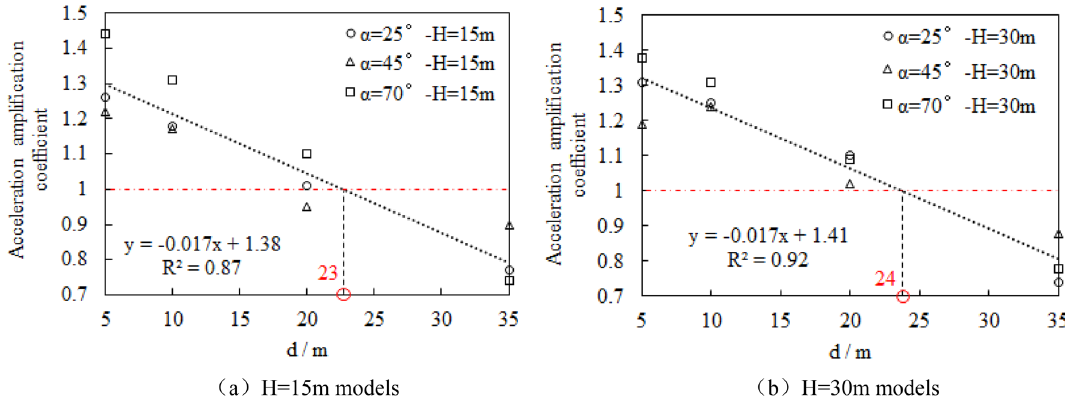
Figure 12. Variation curve of soil acceleration amplification coefficient at building foundation on top slope with building distance of d .